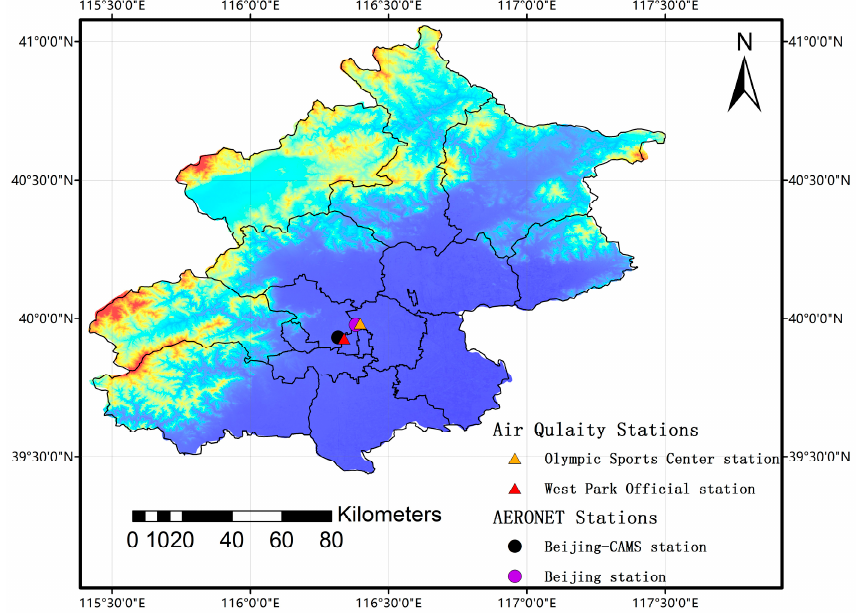
Figure 1. Distributions of the two Aerosol RObotic NETwork (AERONET) stations and two air quality stations used in this study. The two AERONET stations are: Beijing-CAMS station (39.93°N, 116.32°E) and Beijing station (39.97°N, 116.38°E). The two air quality stations are Olympic Sports Center station (39.98°N, 116.40°E) and West Park Official station (39.93°N, 116.34°E).